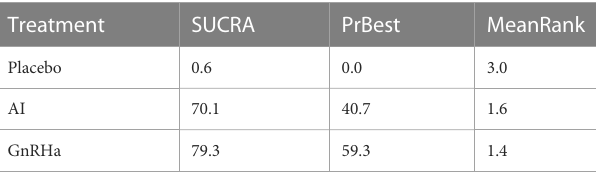
TABLE 2 Ranking for the treatments in the network